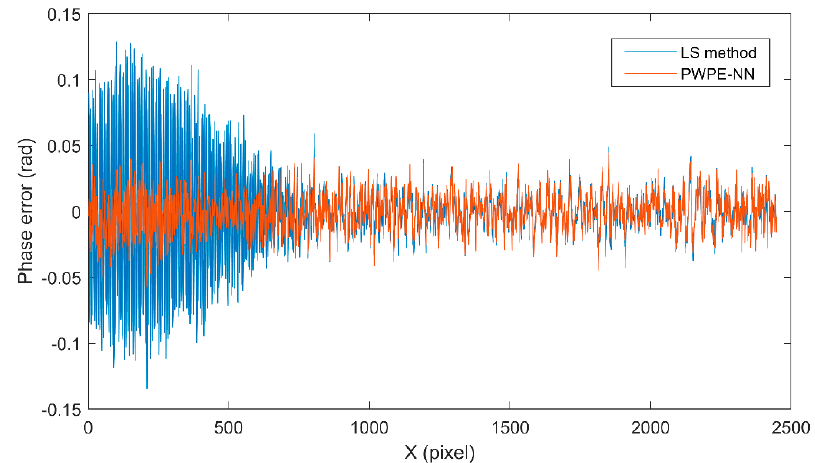
Figure 4. Result of one row in trained image.